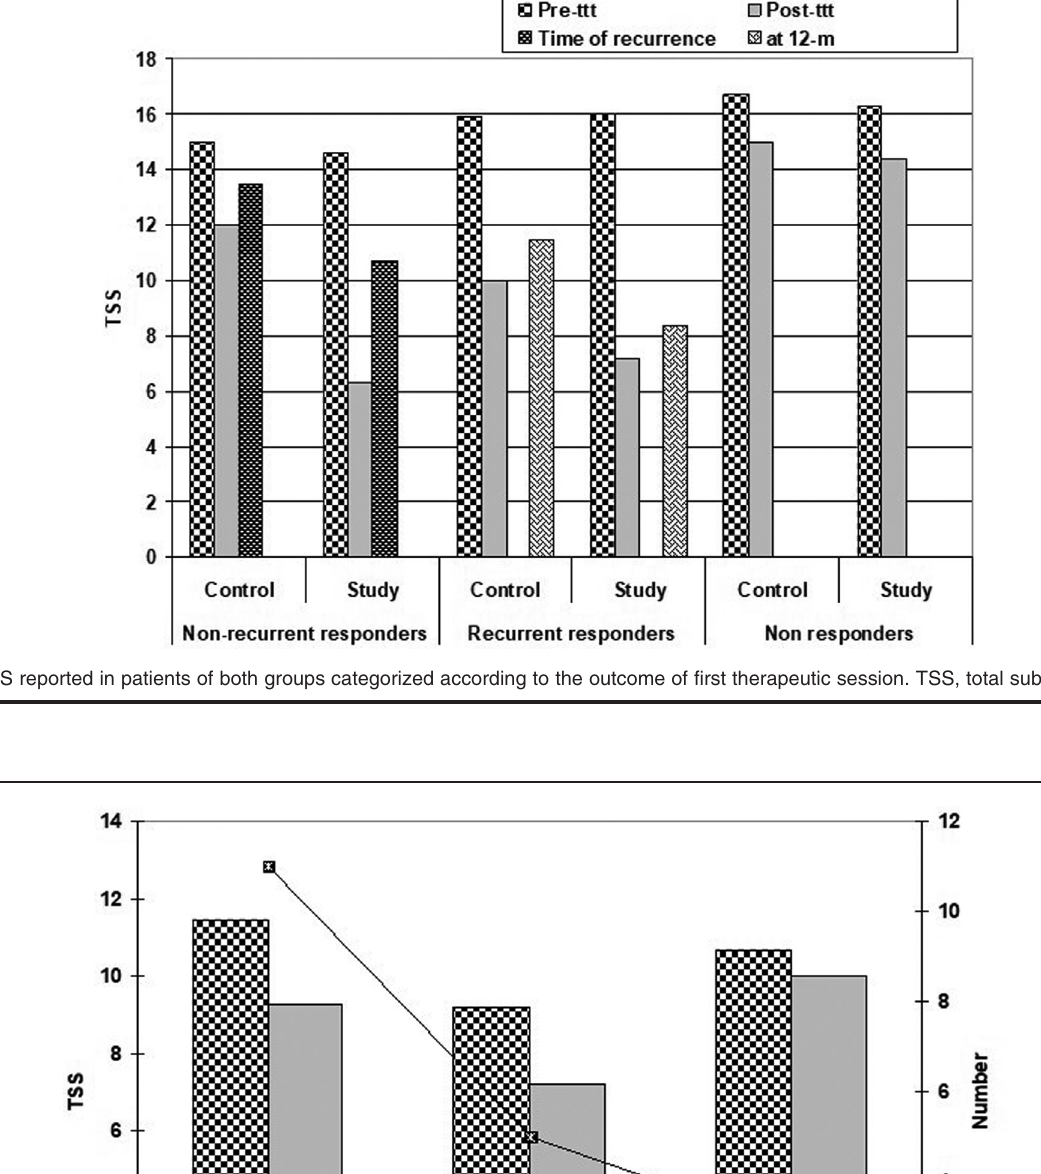
responders were significantly lower than pre-ttt scores ( P = 0.045), while in comparison to CT scores of nonresponders the difference was nonsignificantly ( P = 0.098) lower (Table 4).